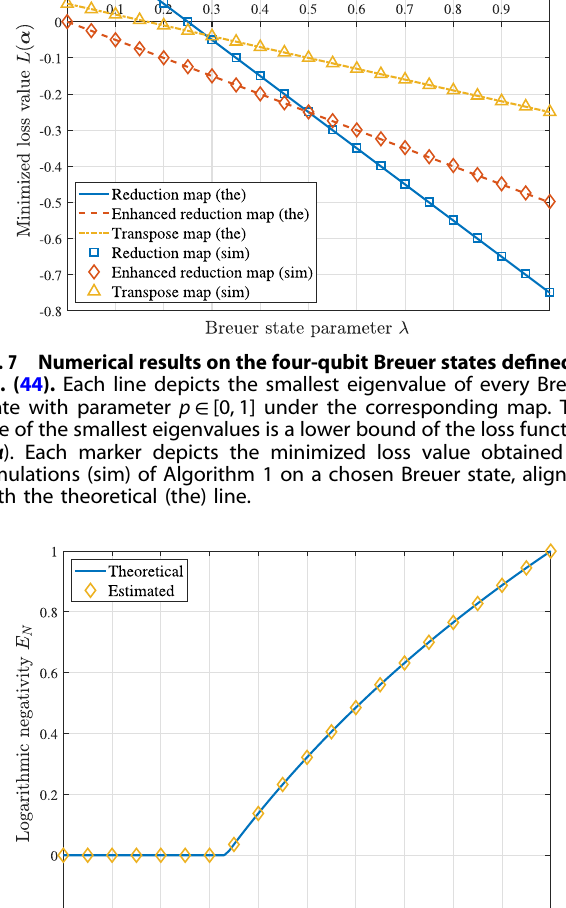
Table 1. Estimated λ min by VED using the reduction criterion on isotropic states with up to 10 qubits and the noise parameter p = 0.7.